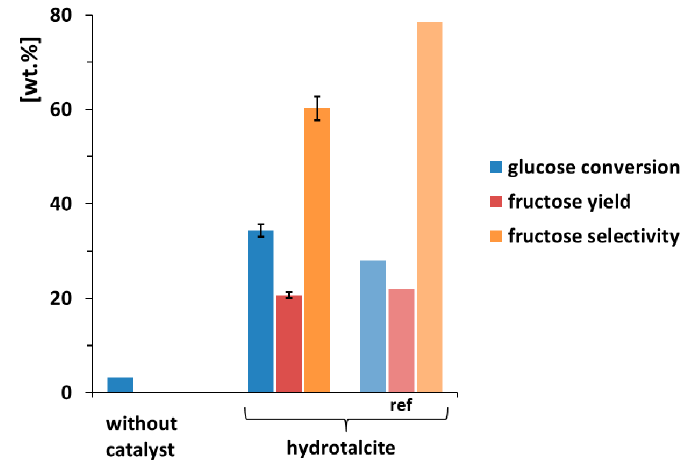
Figure 2. Glucoseconversionandfructoseyieldusingcalcinatedhydrotalcite,comparedtoLecomteetal.[15] Figure 2. Glucose conversion and fructose yield using calcinated hydrotalcite, compared to Lecomte (ref), c glucose = 100 g / L, T = 90 ◦ C, t = 60 min, air atmosphere, m catalyst / m glucose = et al. [15] (ref), c glucose = 100 g/L, T = 90 °C, t = 60 min, air atmosphere, m catalyst /m glucose = 0.2.